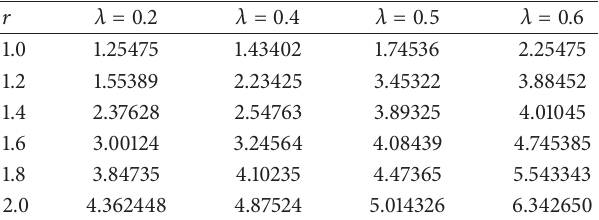
Table 8: Thickness of coated wire for various values of 𝜆 when